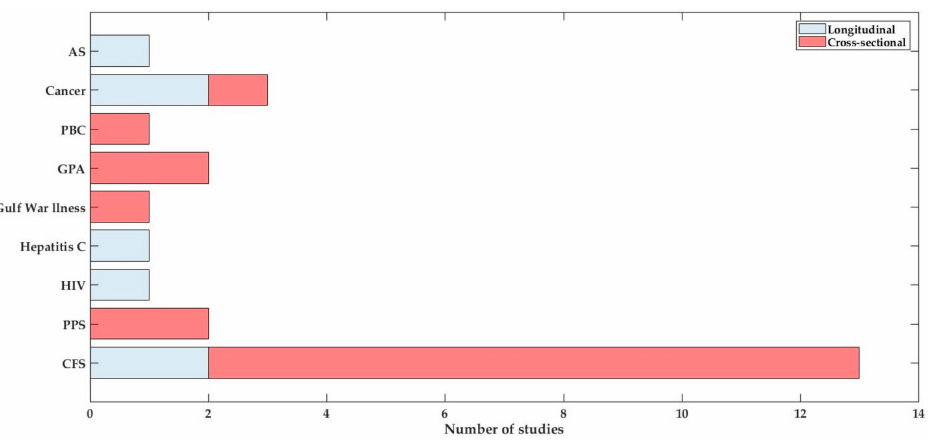
Figure 2. Distribution of longitudinal and cross-sectional studies per